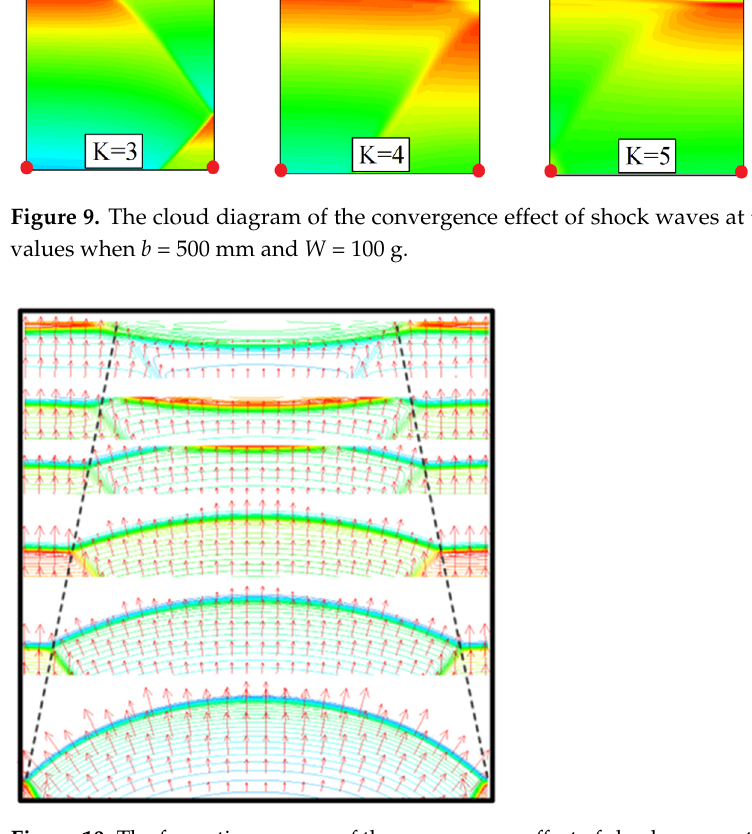
Figure 10. The formation process of the convergence effect of shock waves at the corner when K = 2.4.